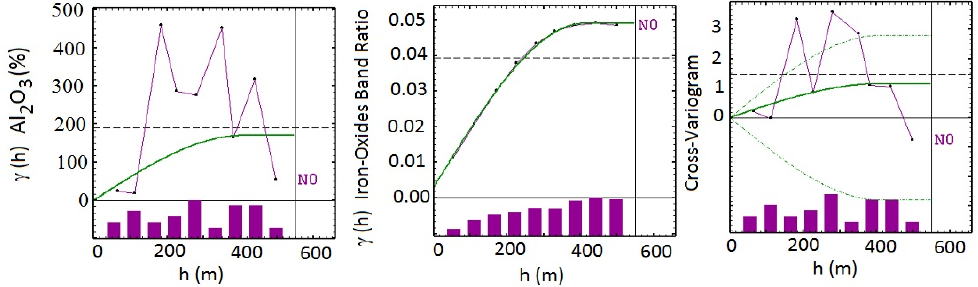
Figure 8. Direct and cross sample variogram (purple) and the fitted model (green line) based on aluminum samples and iron oxides band ratio from PRISMA Image.